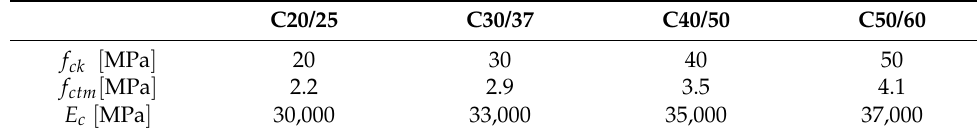
Table 1. Excerpt of strength-based classifications of concrete according to European codes [24];